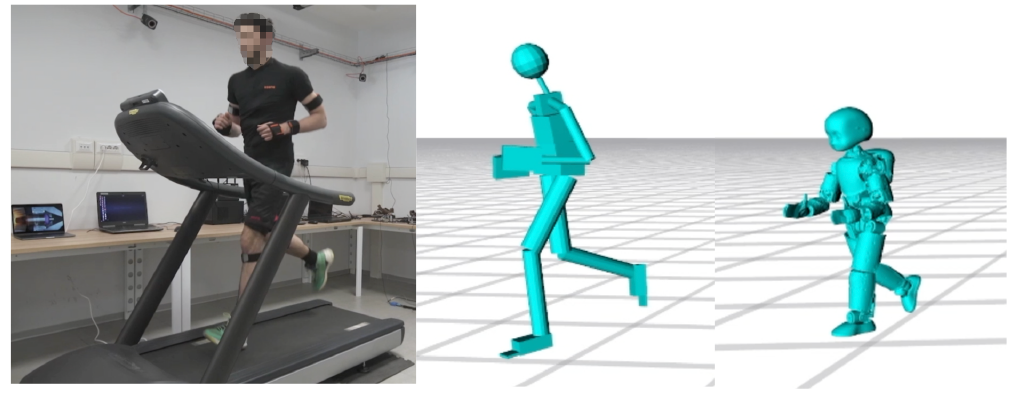
Figure 1. Motion tracking of a human running on a treadmill using an human model, on the center, and a humanoid model, on the